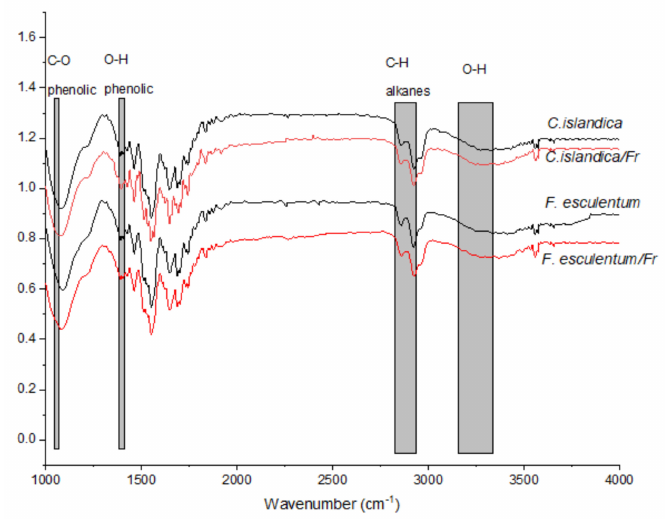
Figure 4. FTIR spectra of the bio-reduced AgNPs using enzyme-assisted (in Figure 1 labeled as F. esculentrum / Fr and C. islandica / Fr ) and control (in Figure 1 labeled as F. esculentrum and C. islandica ) C. islandica and F. esculentum extracts.